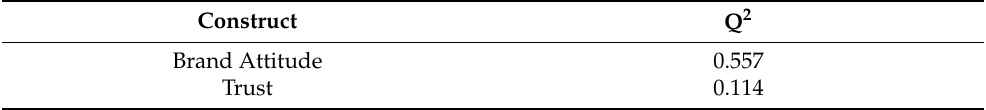
Table A7. Predictive Relevance of Full Sample (N = 45).